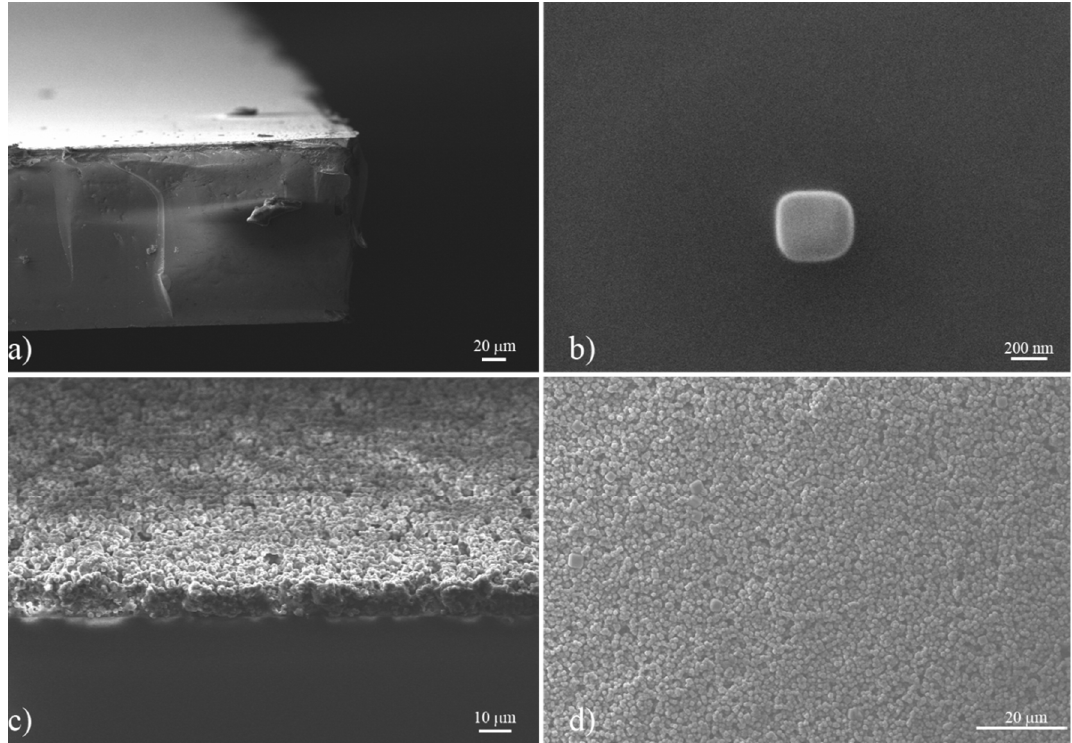
Figure 3. SEM images of: ( a ) the glass substrate; ( b ) the nanoporous grain composing the mixture; ( c ) the deposited composite layer after annealing process; and ( d ) the upper view of the layer.